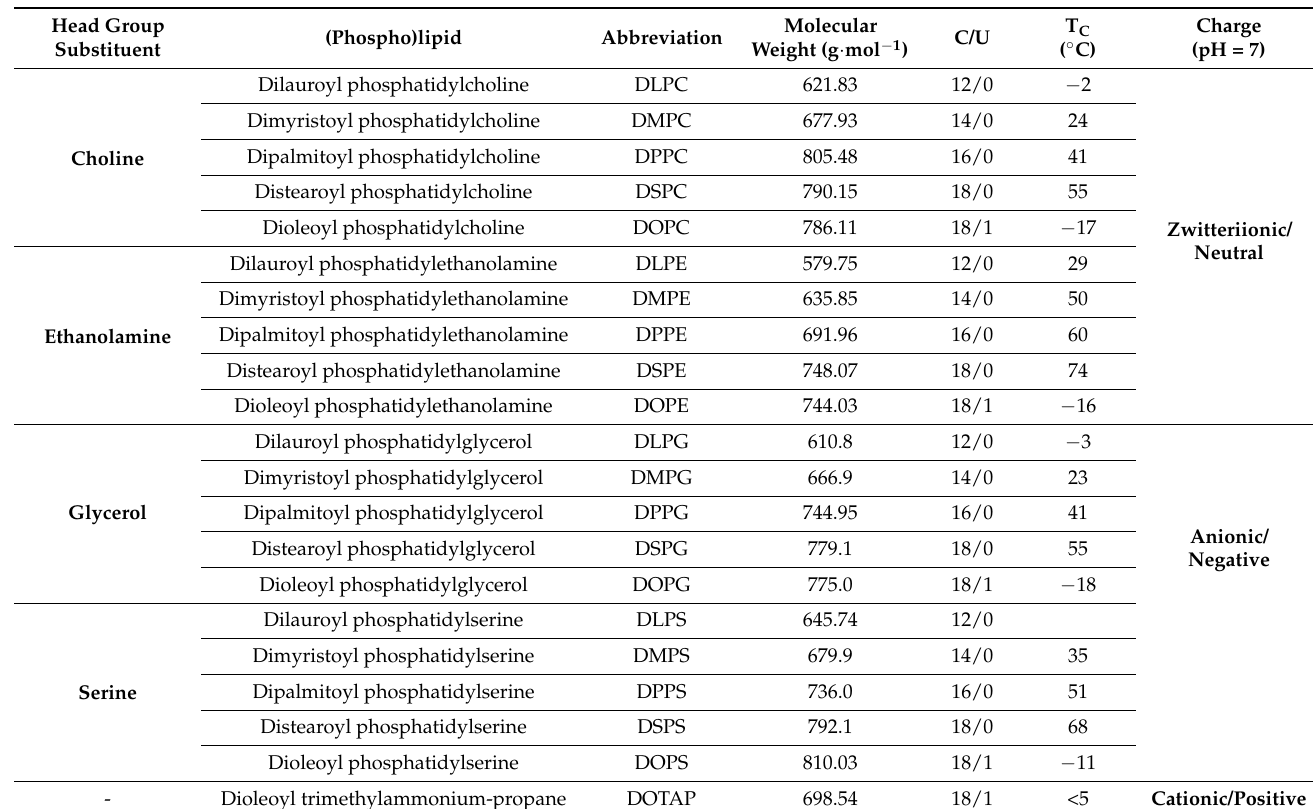
Table 1. Commonly used (phospho)lipids for liposome